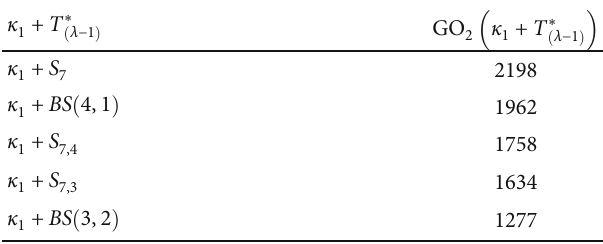
Figure 5: 1-apex tree. 1 -apex trees of order 8. Table 2: GO 2 value of some